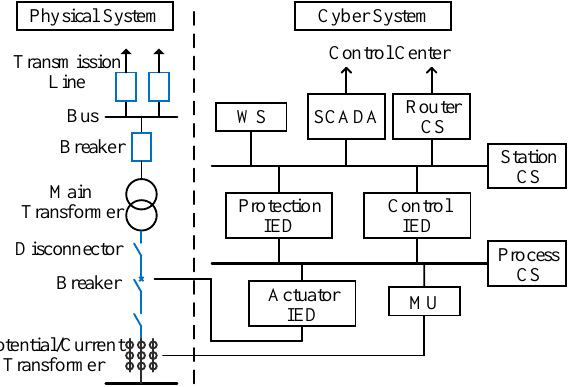
Figure 2. Cyber-Physical System (CPS) structure in a substation.